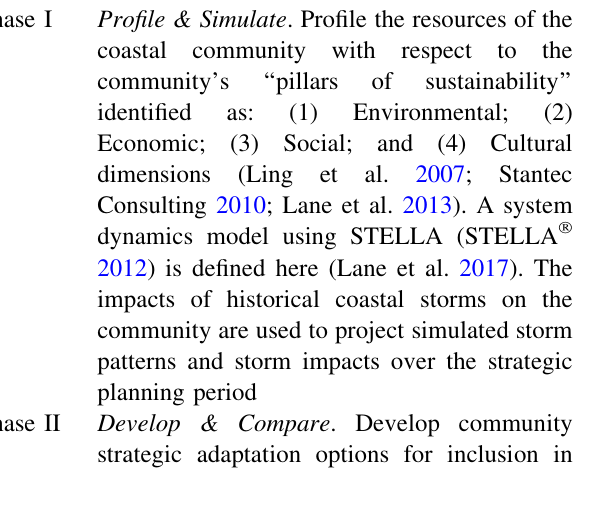
Fig. 2 Framework for adaptation and community evaluation